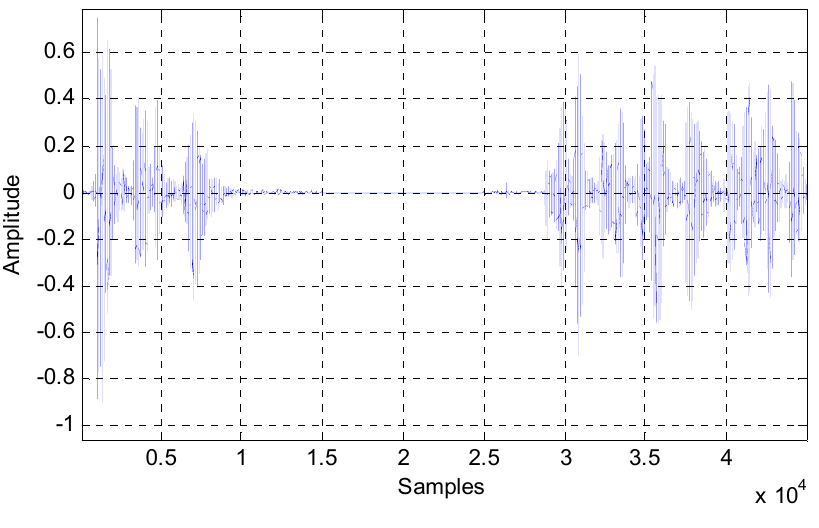
Figure 2. A typical one end telephone